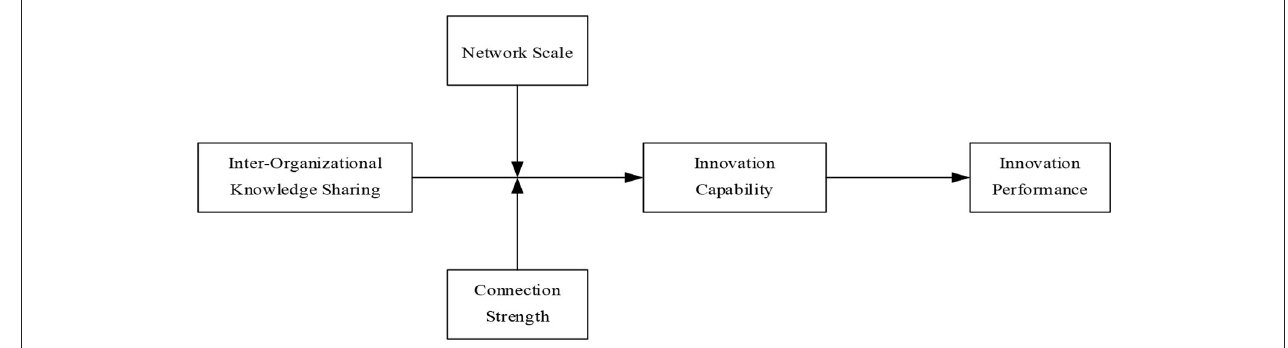
FIGURE 1 | Theoretical